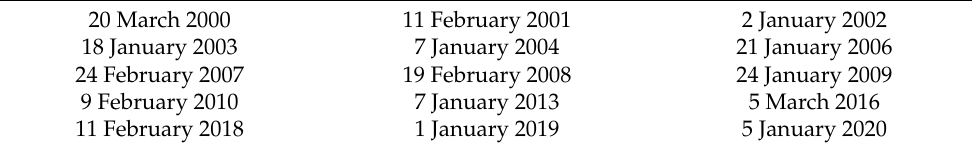
Table 1. Central dates of major SSWs in the Northern Hemisphere from 2000 to